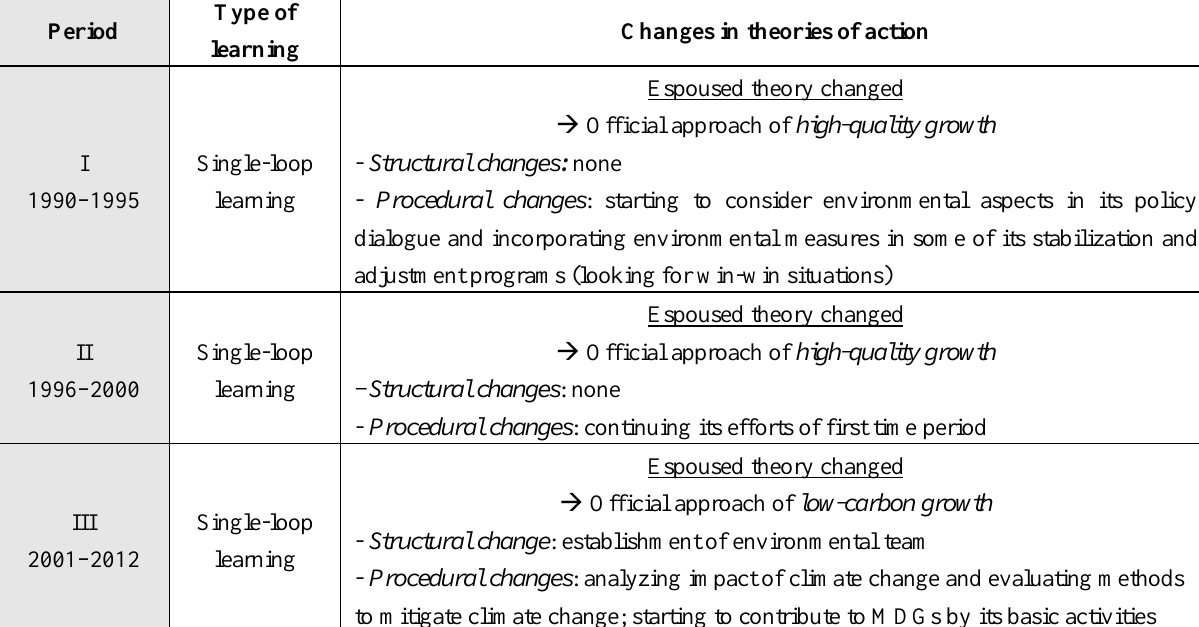
Table 3. Organizational Learning Within the International Monetary Fund